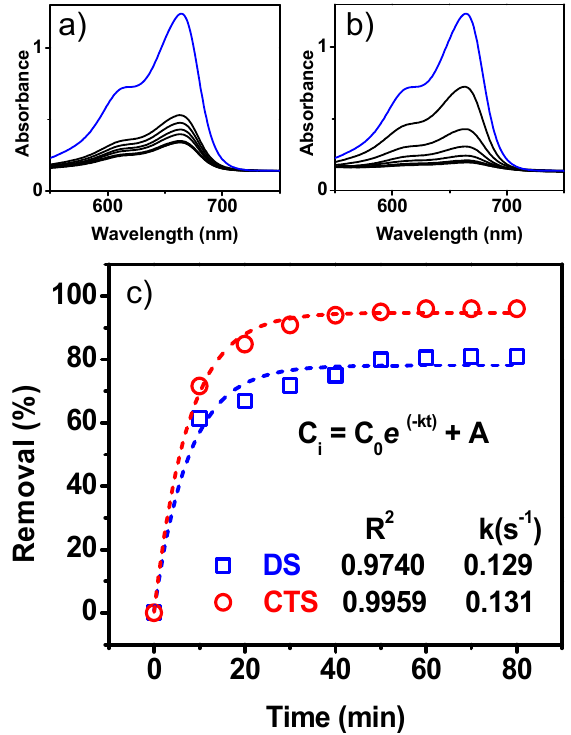
Figure 4. Evaluation of chemical modifications to Sargassum spp. in methylene blue removal: ( a ) and ( b ) Ultraviolet-Visible (UV-Vis) spectra of methylene blue using dry Sargassum spp. (DS) and CT- Sargassum spp. (CTS), respectively. ( c ) Methylene blue removal rate curves.